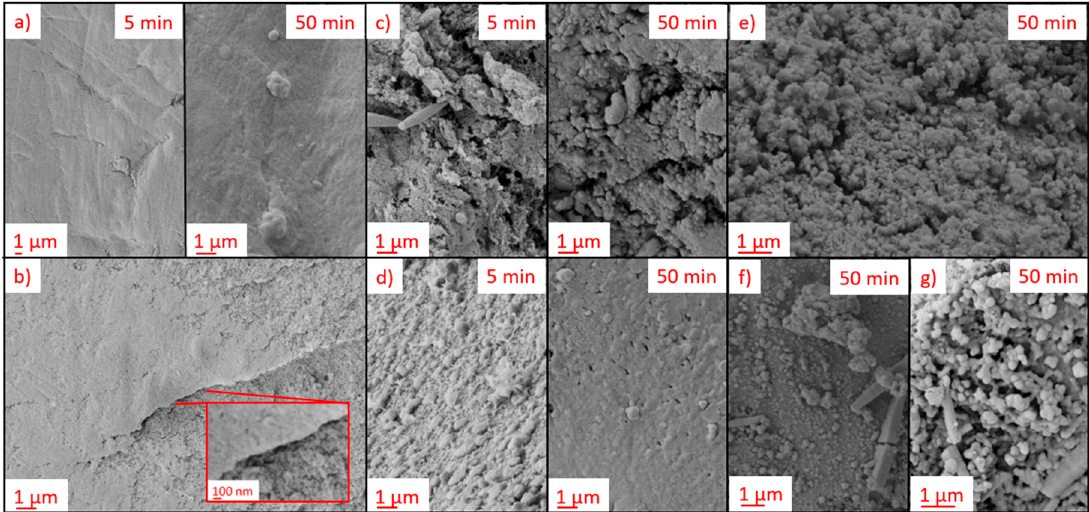
Figure 4. SEM pictures of external coating on different aerogels: ( a ) alginate, C 4 F 8 , CW, p input = 90 W, ( b ) WPI, C 4 F 8 , CW, p input = 90 W, ( c ) cellulose, C 4 F 8 , CW, p input = 90 W, ( d ) PPI, C 4 F 8 , CW, p input = 90 W, ( e ) alginate PFAC8, CW, p input = 30 W, ( f ) PPI, PFAC-6, CW, p input = 90 W, ( g ) PPI, PFAC-8, CW, p input = 30 W.